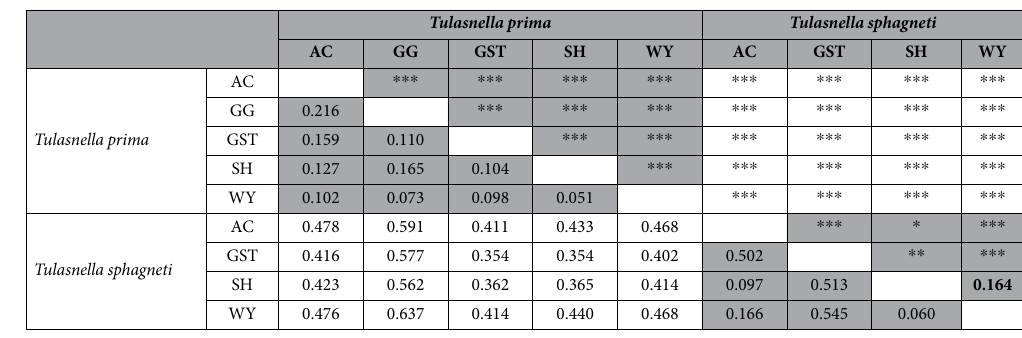
Table 6. Pairwise F st results for within (shaded areas) and among Tulasnella taxa for Kosciuszko National Park sites. All 10 microsatellite loci were included for Tulasnella prima pairwise site comparisons, and four microsatellite loci for among taxa comparisons, and within Tulasnella sphagneti pairwise site comparisons. Bottom triangle shows F st values and top triangle shows probability values for F st , non-significant probabilities are highlighted in bold. *** P values from 0.001, ** ≤ 0.025, * ≤